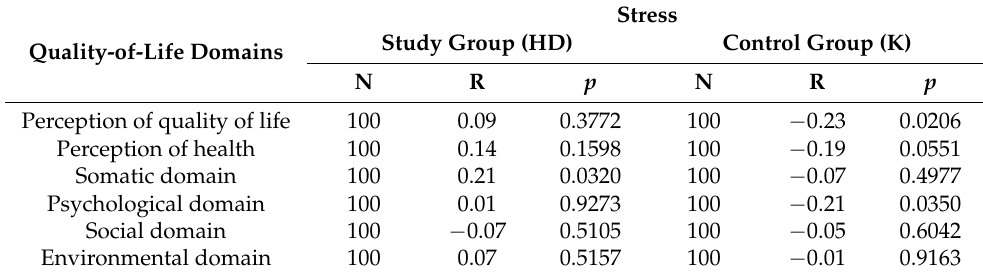
Table 5. Quality of life and stress in the study group (HD) and the control group (K).